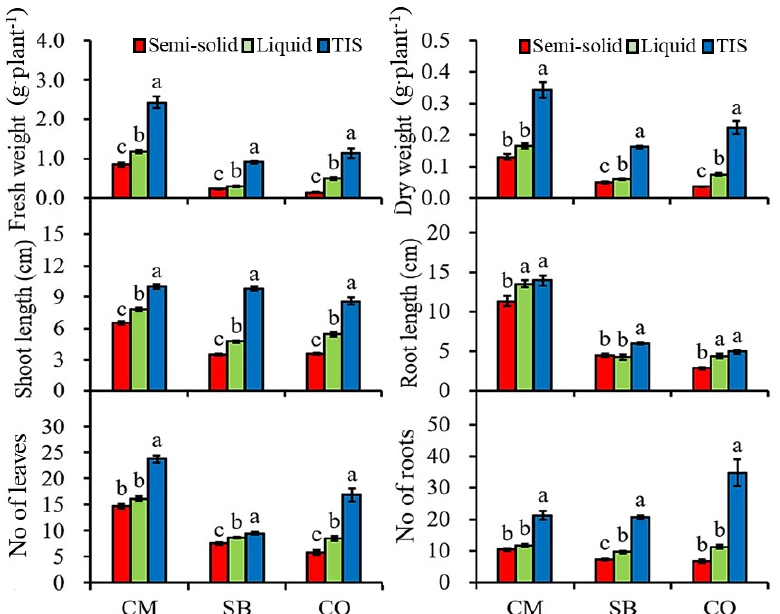
Figure 1. Fresh weigh, shoot length, and leaf number of chrysanthemum (CM), strawberry (SB), and Cnidium officinale (CO) plants after 4 weeks in semi-solid, liquid, and TIS cultures. Bars with different letters differ significantly from each other by Duncan’s multiple-range test (DMRT; p ≤ 0.05).